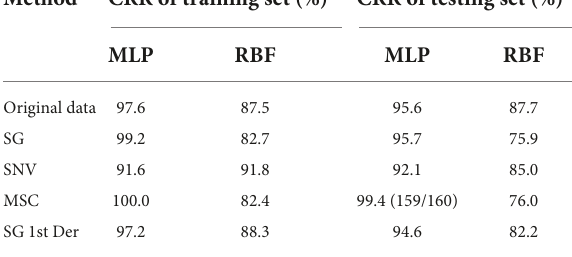
TABLE 5 Summary of ANN modeling results for bacteria species identification expressed in